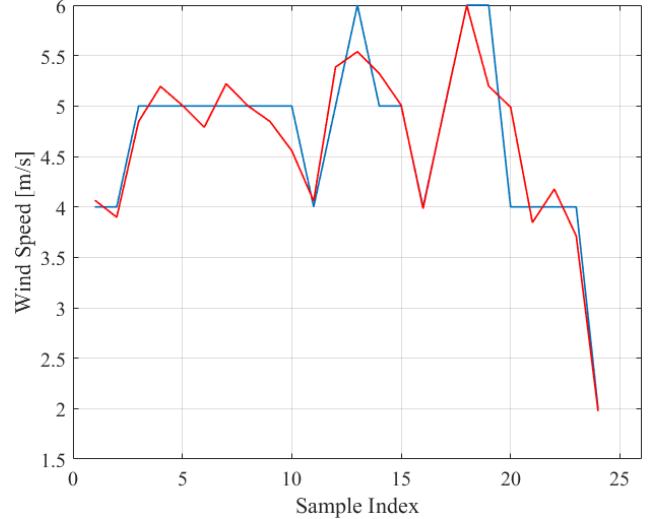
Figure 30. Actual (blue) and predicted (red) wind speed in the middle of May 2016.